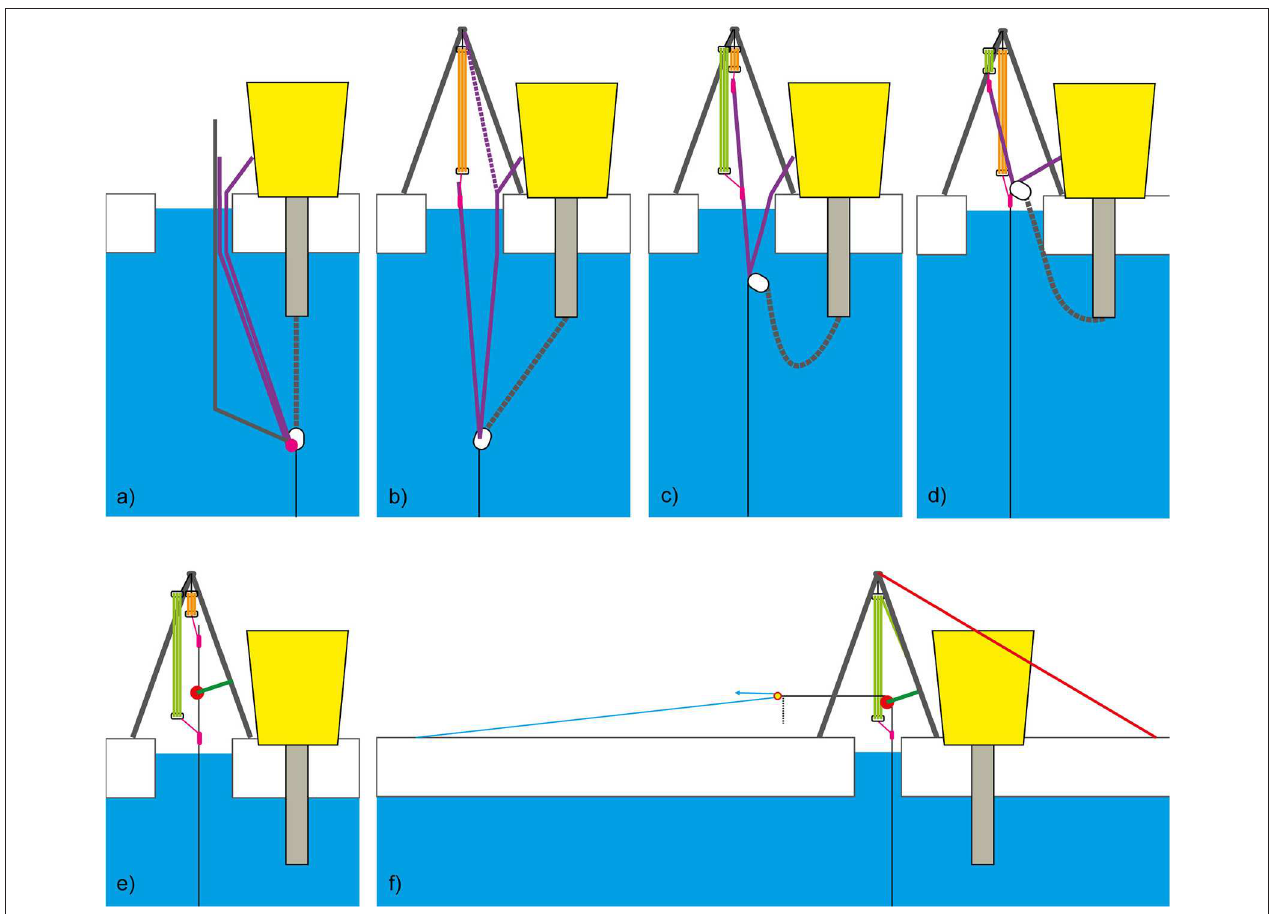
FIGURE 4 | Sketch of the full sequence of the presented recovery technique. (a) Attachment of a rope loop (purple) to the lowermost clippable point. (b) Raising using first pulley (orange). (c) Extension of lifting range using second pulley (green). (d) Mounting a friction hitch (magenta) on the steel wire (black) and cut chain and subsea electronics from wire. (e) Installation of the main friction hitch and diversion pulley (red). (f) Lifting the profiler using a simple 2:1 running loop pulley (light